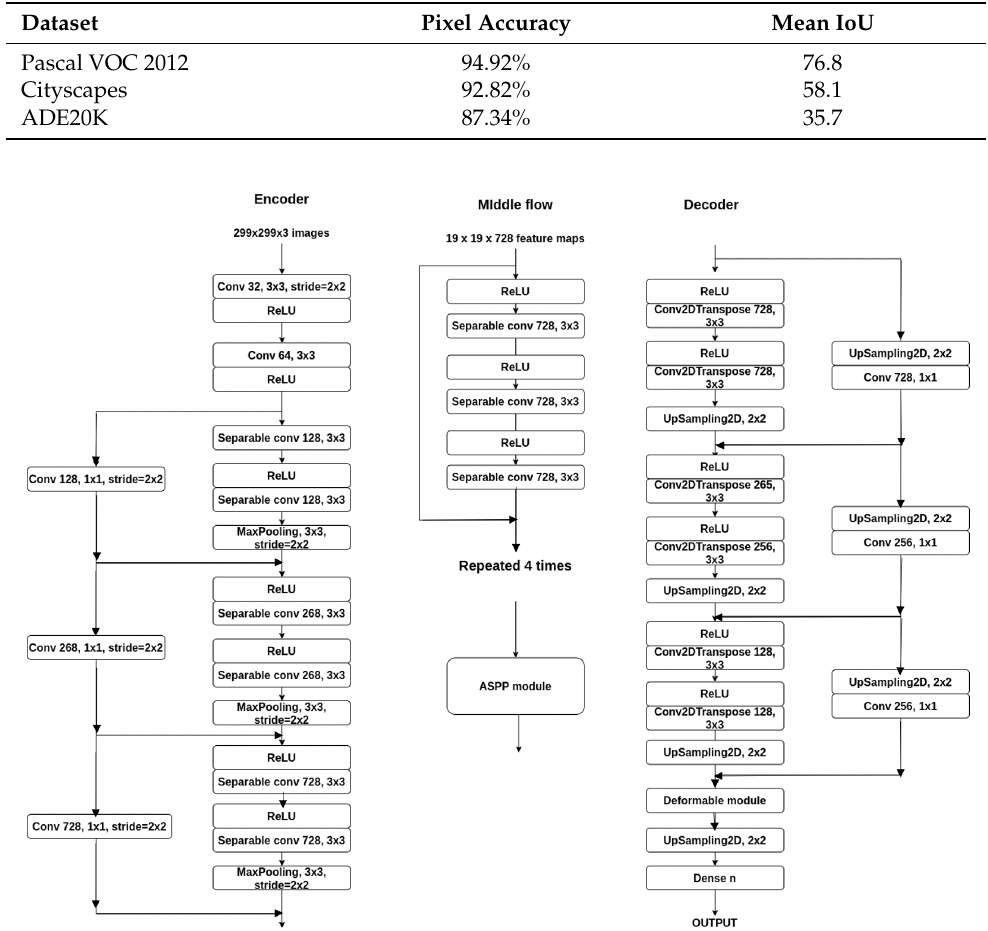
Figure 4. Architecture of the best proposed